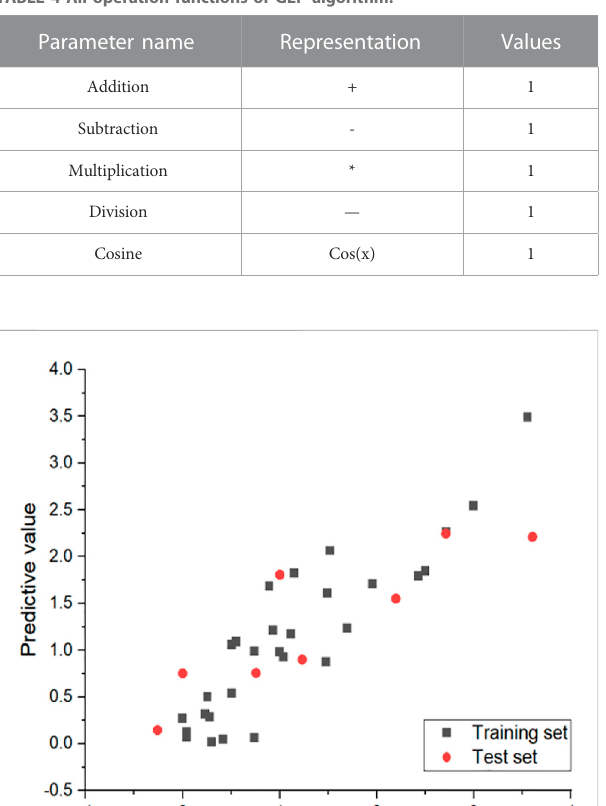
TABLE 4 All operation functions of GEP algorithm.